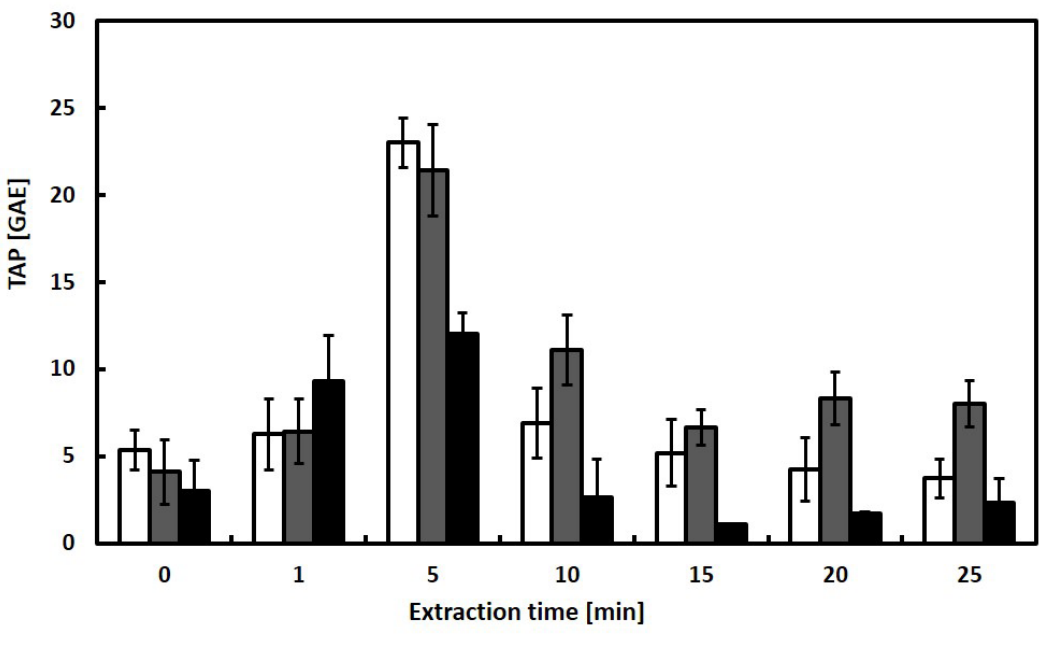
Figure 6B: The dependence of TAP of chicken fillet (500 mg/mL) on time of extraction in acetone (white), methanol (gray) and hexane